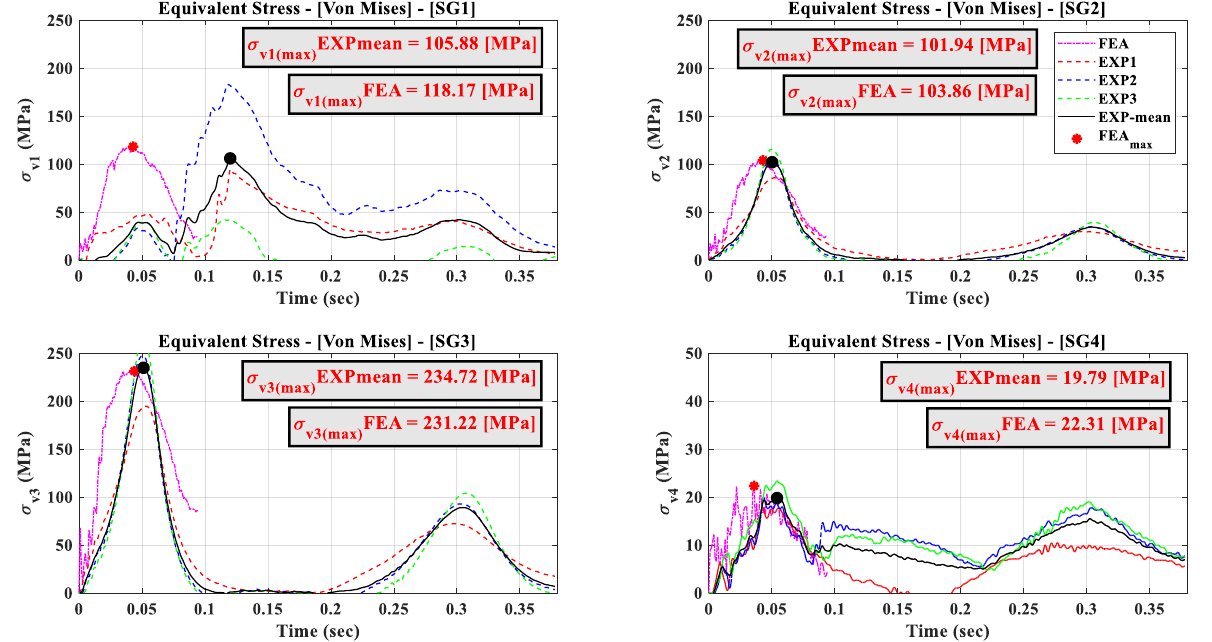
Figure 11. Comparison of experimentally measured (dashed lines) and numerically determined (continuous line) equivalent (von Mises) stress time histories, together with the maximum value of this stress, at the locations (SG1–SG4) during in situ fail scenarios.